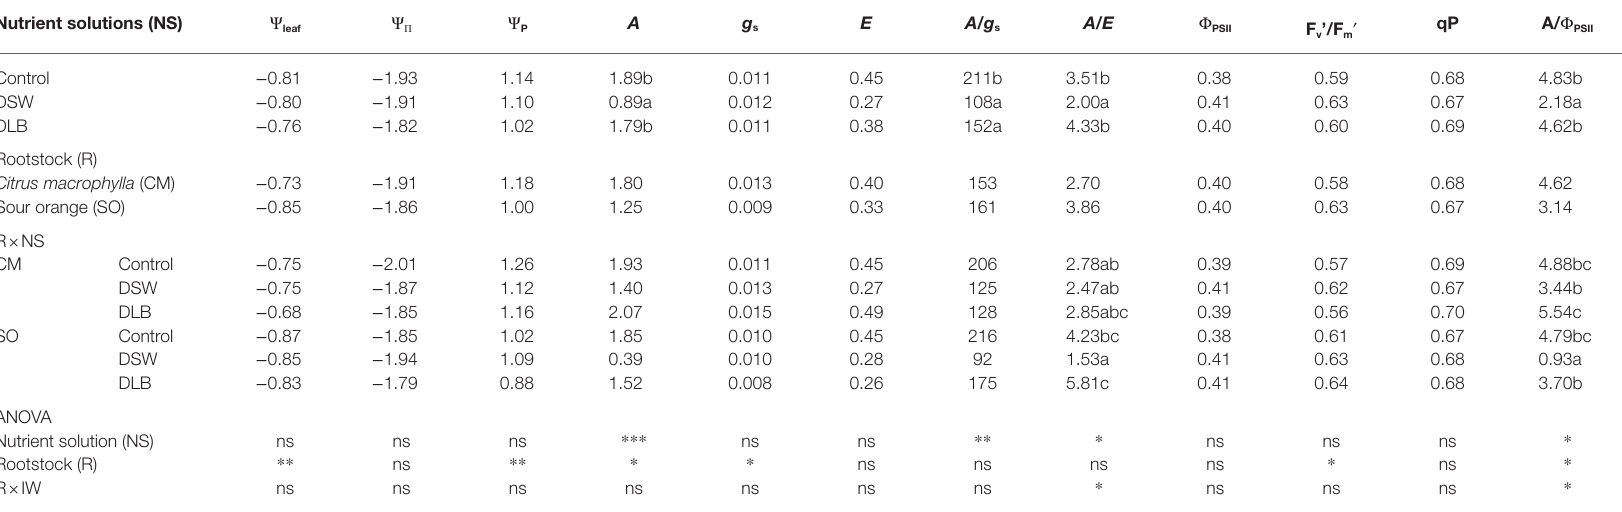
TABLE 6 | Effects of irrigation with nutrient solutions of different characteristics—Control, DSW, and DLB—and the rootstock on the plant water relations, gas interchange, and chlorophyll fluorescence parameters of ‘Verna’ lemon plants grown on two rootstocks, Citrus macrophylla (CM) and sour orange (SO). Nutrient solutions